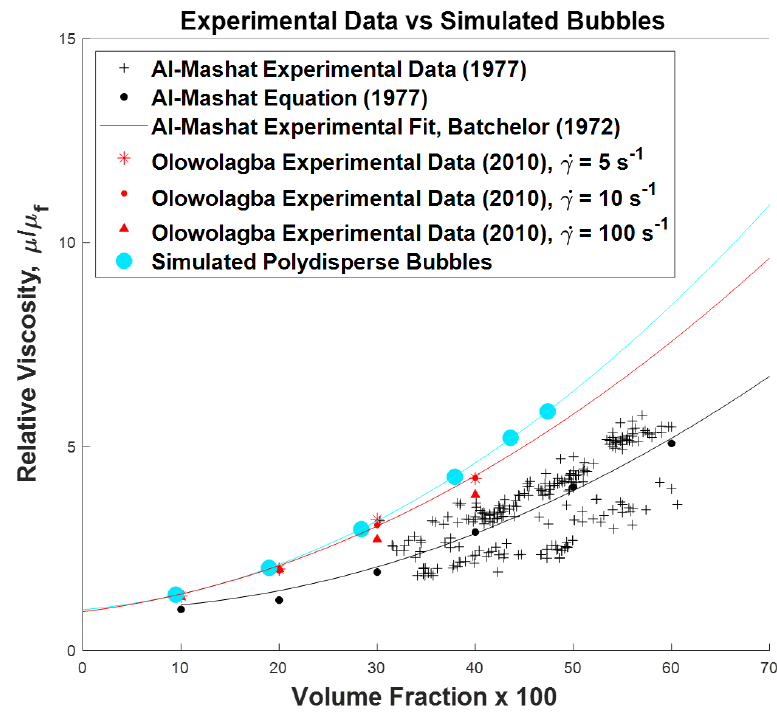
Figure 4. The relative viscosity determined from the simulated results is shown with the experimental data of Al-Mashat [40] and Olowolagba